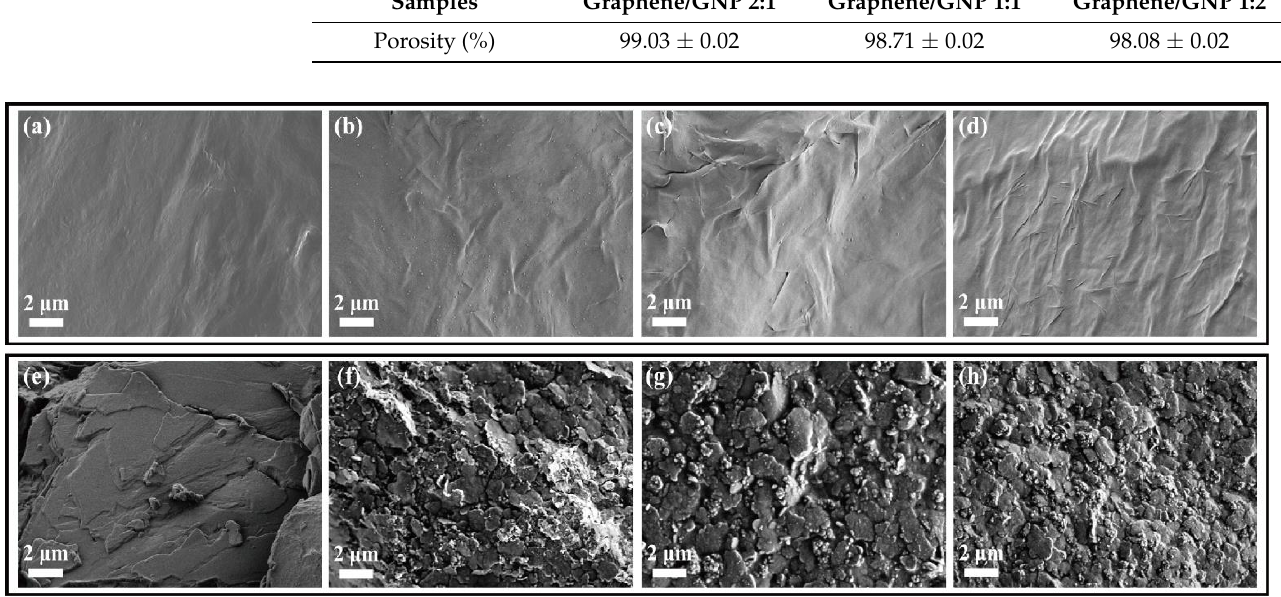
Table 3. Porosities of rGO/GNP aerogels with different GNP mass ratios. Figure 5. ( a ) Weight percentage of PEG and 1-TD in the PCM composite and ( b ) porosity of rGO/GNP aerogels. XRD peaks of ( c ) pure PEG and PEG composites and ( d ) pure 1-TD and 1-TD composites. Thermal conductivities of ( e ) pure PEG and PEG composites and ( f ) pure 1-TD and 1-TD composites.